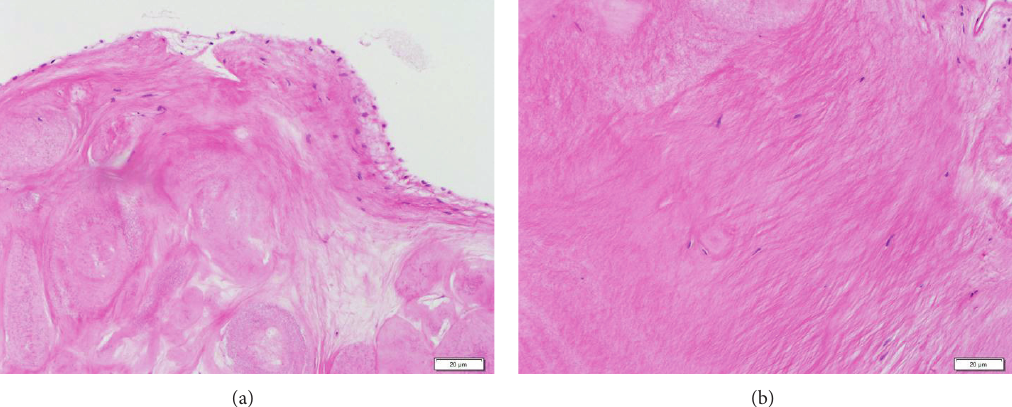
F3:Microscopicalanalysisoftheresectedspecimenrevealedasinglesquamouscelllayercoveringthesurface(a),andacorecomprising aggregated elastic �bers and hyaline material